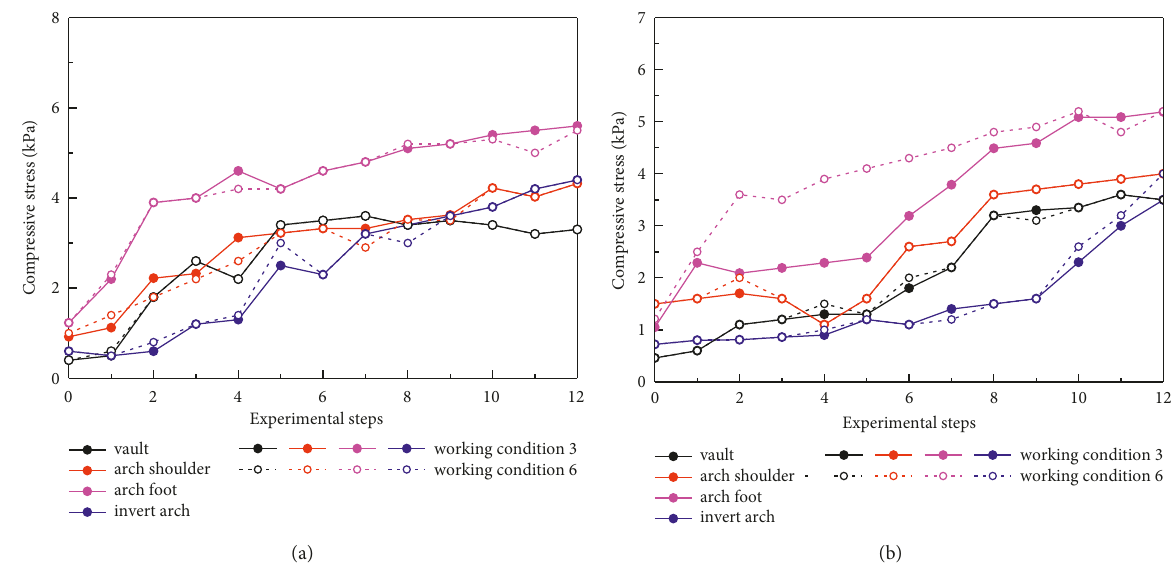
Figure 13: Variation of lining stress at different measure points (working conditions 3 and 6). Lining stress variation at the (a) left measure points and (b) right measure points.